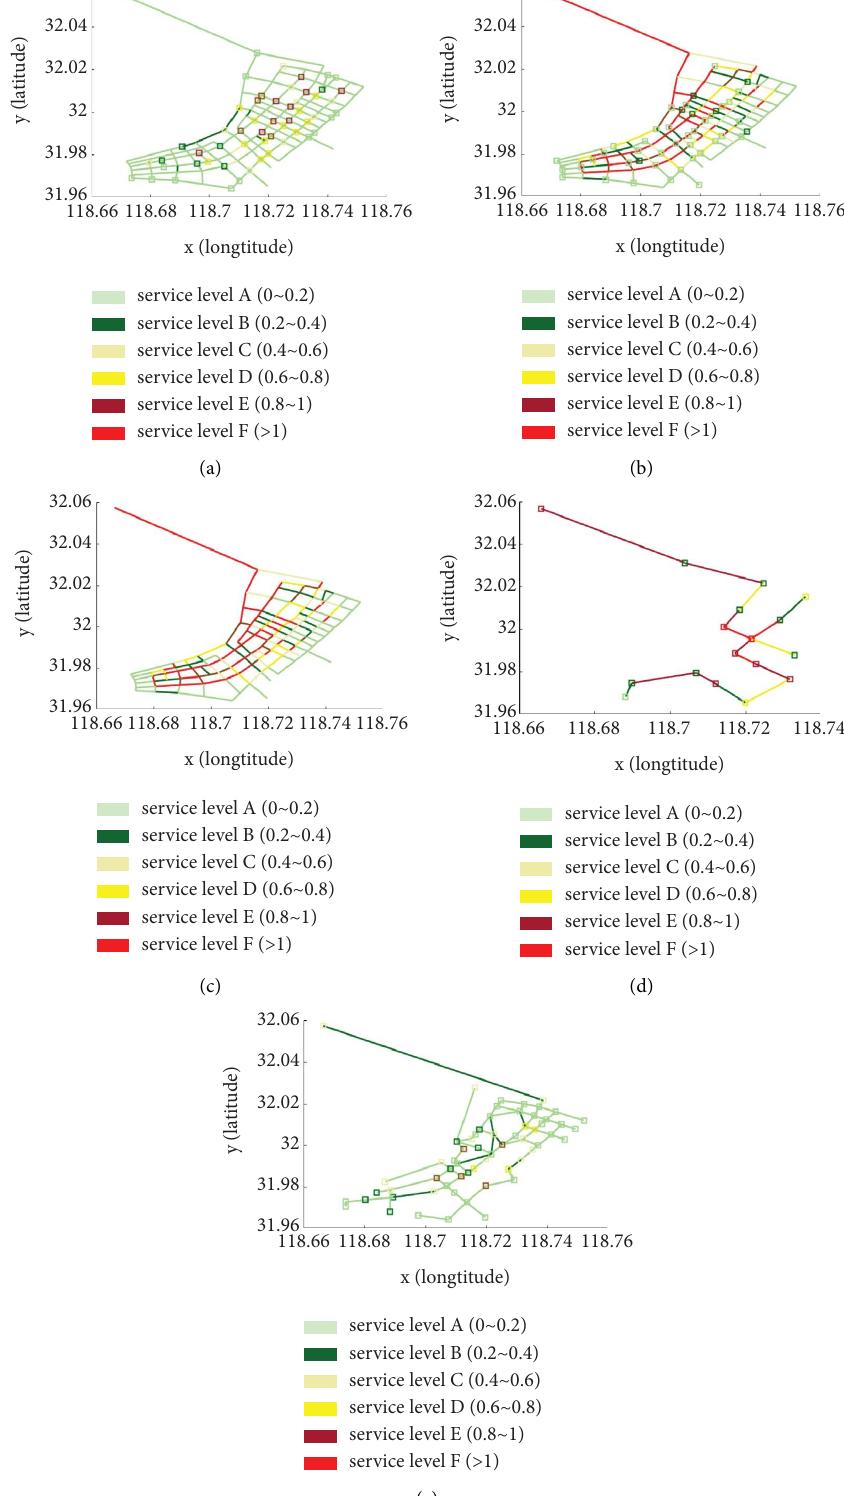
Figure 14: Service level of original network. (a) Bicycle subnetwork. (b) Car subnetwork. (c) Car hailing subnetwork. (d) Metro subnetwork. (e) Bus